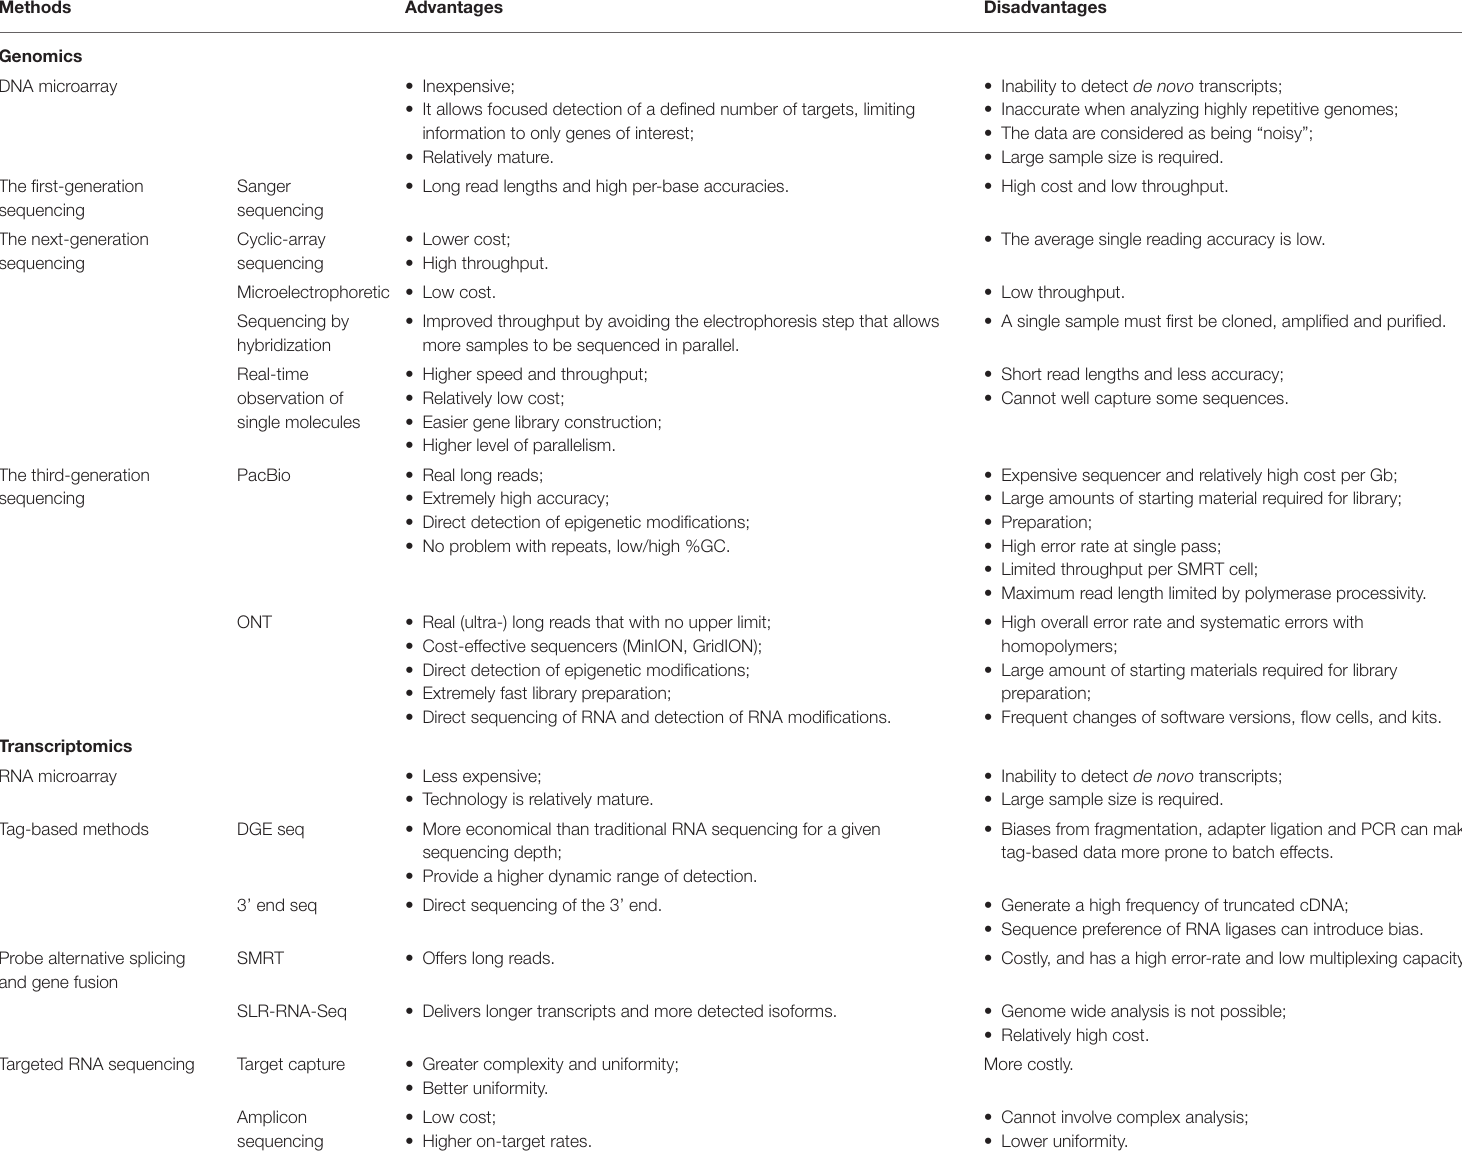
TABLE 1 | Comparisons of high-throughput approaches for omics